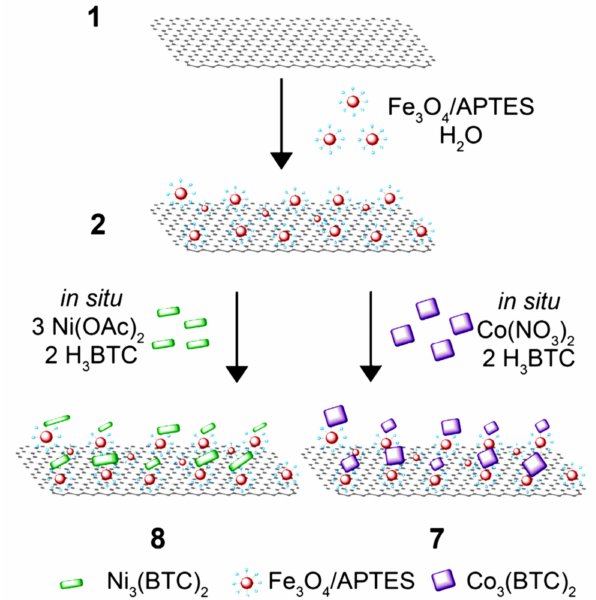
Figure 21. Synthesis of the Fe 3 O 4 -Ni 3 (BTC) 2 @GO and Fe 3 O 4 -Co 3 (BTC) 2 @GO nanocomposites. Reprinted with permission from